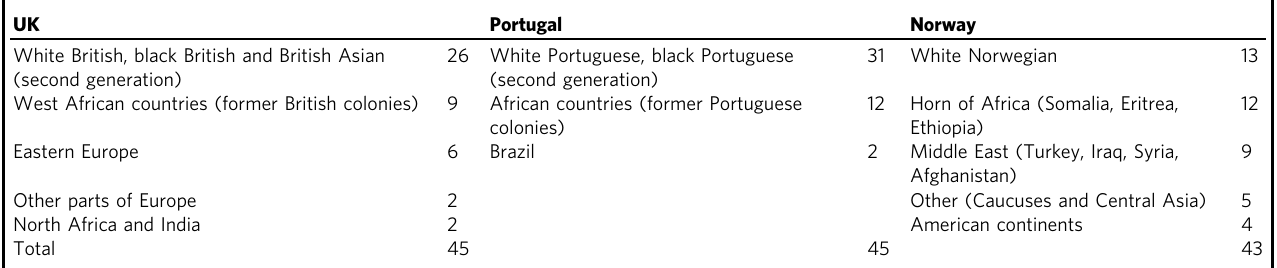
Table 2 Origins of study mothers in the three countries ’ samples.